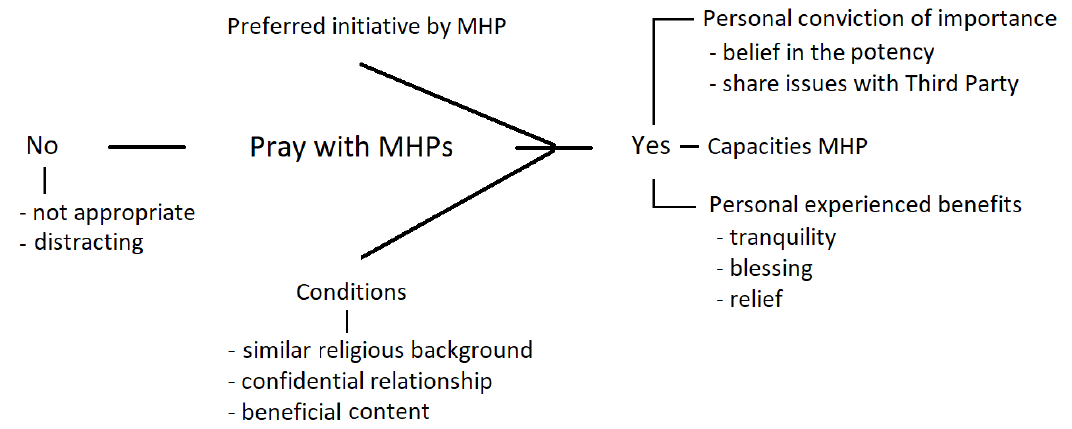
Figure 2. Opinions of patients.